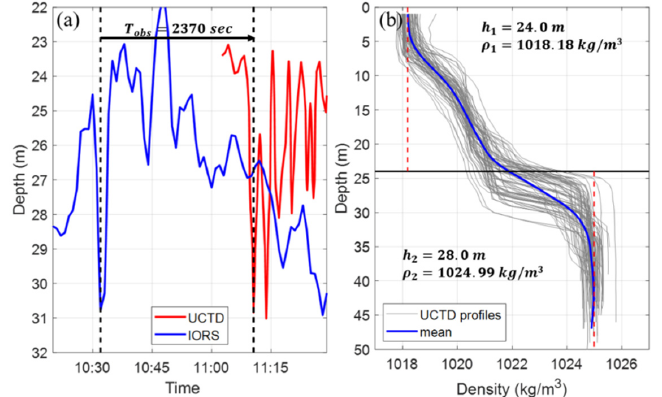
Figure 8. Information related to NLIWs observed at the IORS and UCTD during IORS18. ( a ) Time- series of the depth of the 18 °C isotherm observed at the IORS (red) and UCTD (blue), and ( b ) vertical profiles of density obtained from the UCTD measurements (grey) at 11:02–11:59 UTC on 30 August 2018. In ( b ), the average profile is marked in blue, and minimum and maximum densities at the upper and lower layers (corresponding to ρ 1 and ρ 2 ), respectively, are shown with red dashed